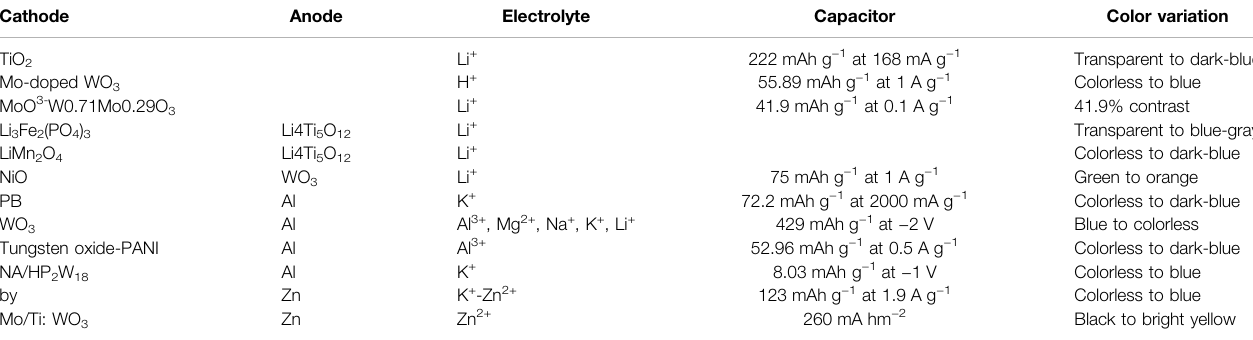
TABLE 2 | Relationship between color variations, capacitance, and cathode and anode materials for PVs (Wang et al., 2020).